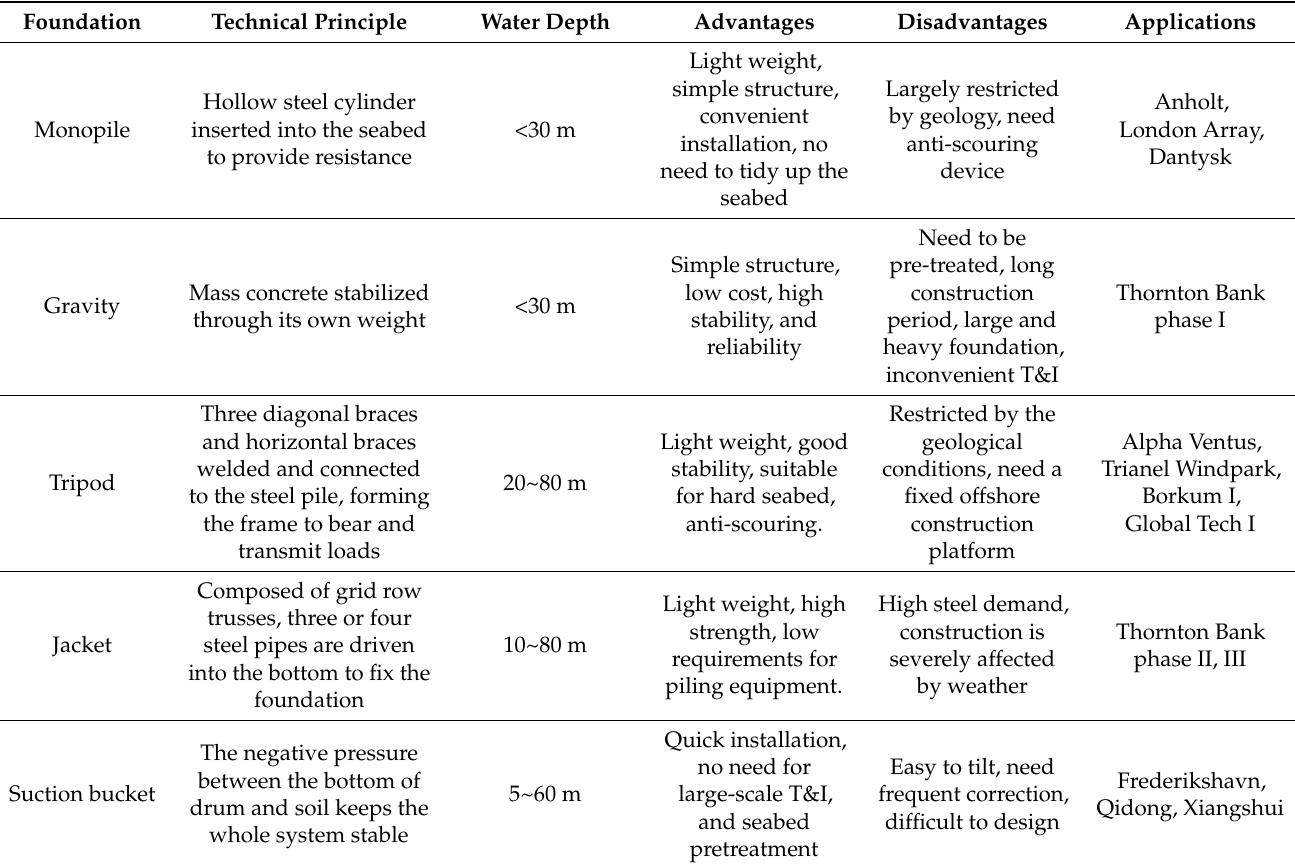
Table 1. Comparison of several fixed foundation